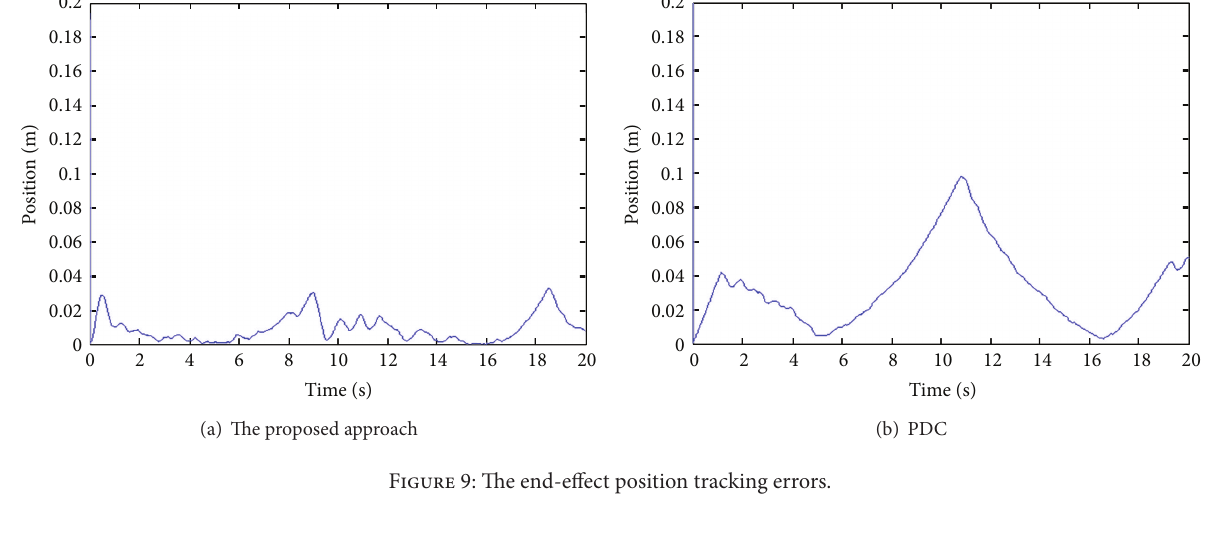
Figure 9: The end-effect position tracking errors.